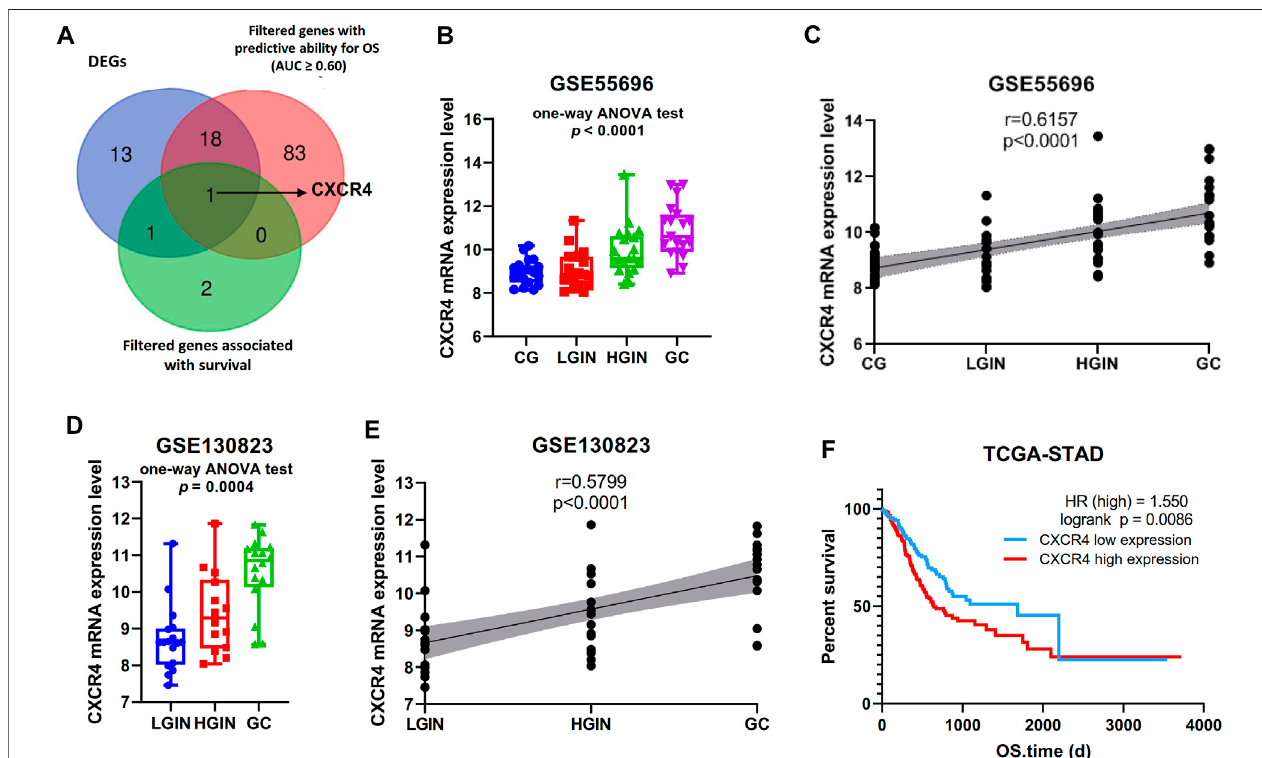
FIGURE 2 | Identi fi cation of novel genes associated with GPL progression to EGC. (A) Venn diagram showing that CXCR4 was the novel gene. (B, D) Gene expression level of CXCR4 in the pathological stage in GSE55696 and GSE130823 cohorts. (C, E) Scatter plot showing the correlation between CXCR4 expression levels and the pathological stage in GSE55696 and GSE130823 cohorts. (F) Survival analysis of CXCR4 in the TCGA-STAD cohort. The patients were strati fi ed into the high-level group and low-level group according to the median expression